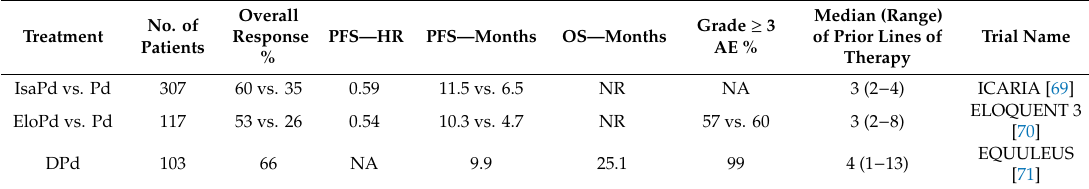
Table 5. Clinical trials in patients with ≥ 3 lines of treatment.